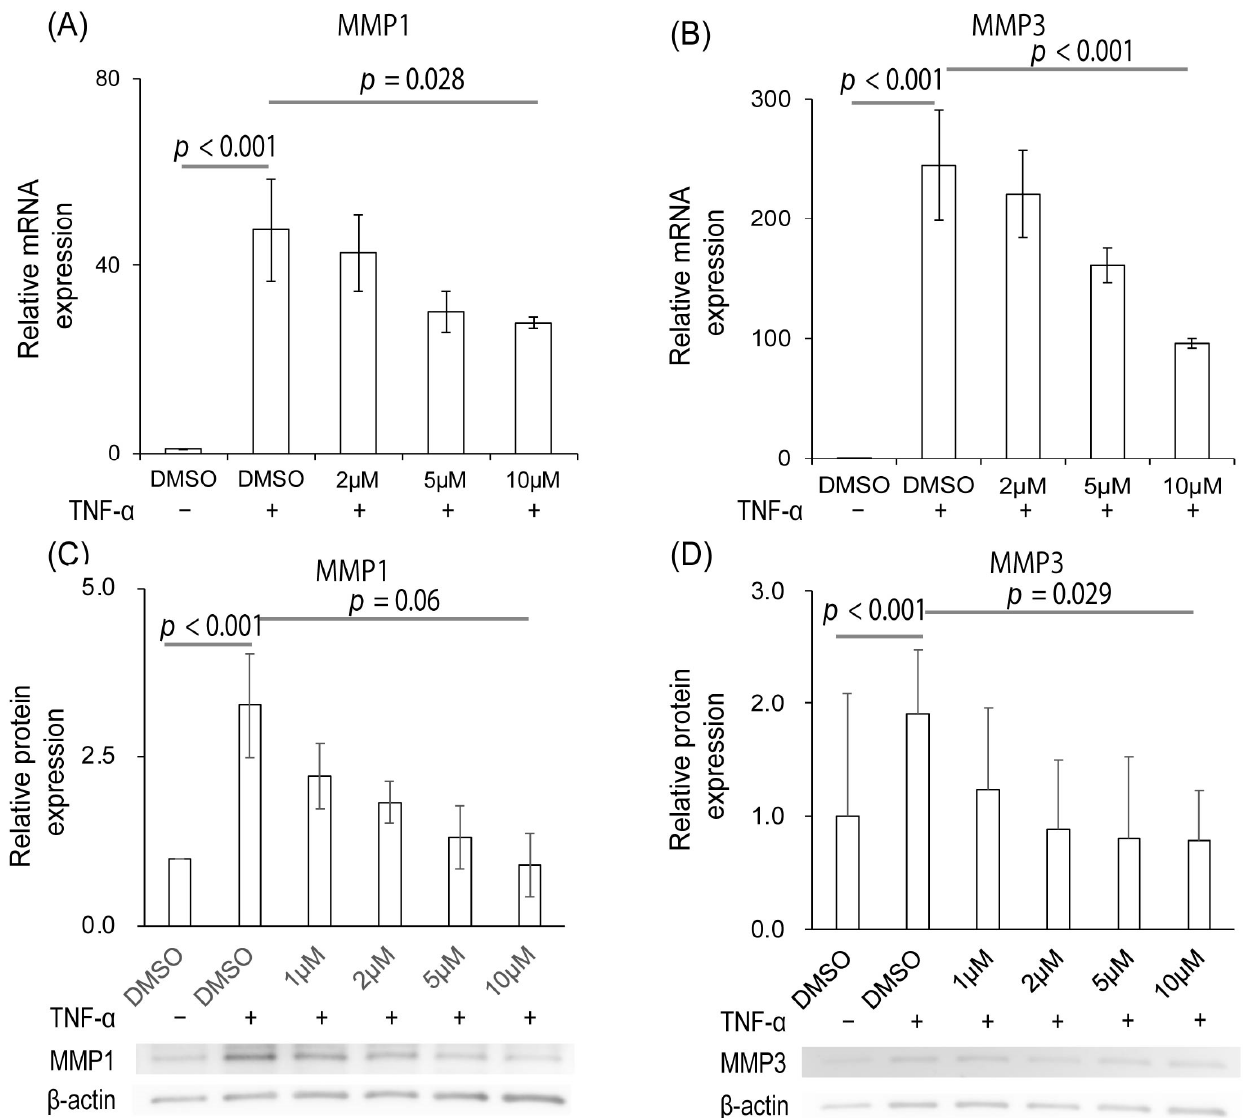
Figure 3. Effects of Ipriflavone on the expression of MMPs in FLS stimulated with TNF- α . ( A , B ) mRNA expression levels of MMP1 ( A ) and MMP3 ( B ) with or without TNF- α and Ipriflavone (2 μ M, 5 μ M, or 10 μ M). ( C , D ) Protein expression levels of MMP1 ( C ) and MMP3 ( D ) with or without TNF- α and Ipriflavone (1 μ M, 2 μ M, 5 μ M, or 10 μ M). Experiments were repeated three times, and